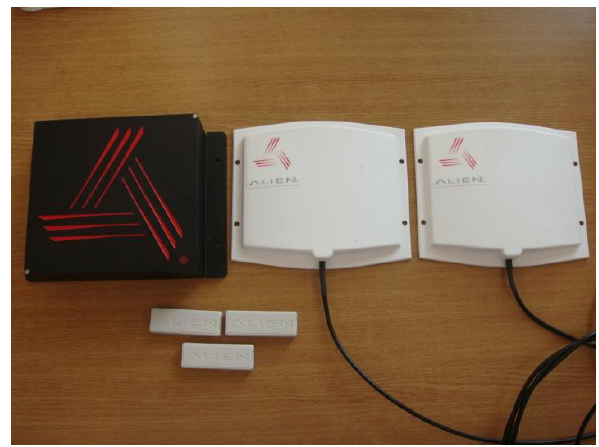
Figure 12. RFID Tag and